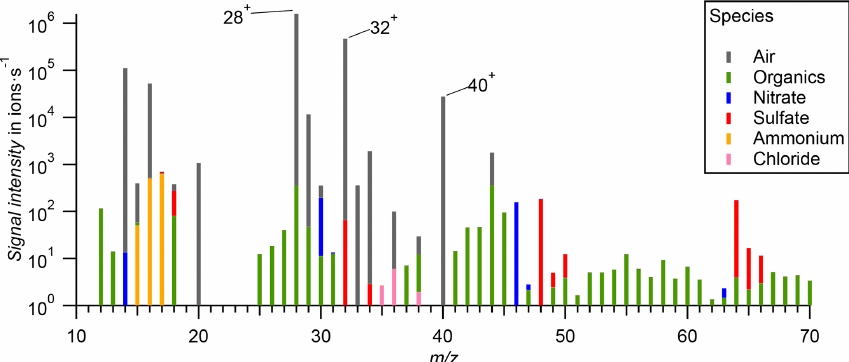
Figure 11. Example of an ambient aerosol average spectrum collected during the field campaign in Kathmandu, Nepal (averaged over the entire campaign period). Cumulative species (air, organics, nitrate, sulfate, ammonium, and chloride) colored according to their fraction in the applied fragmentation